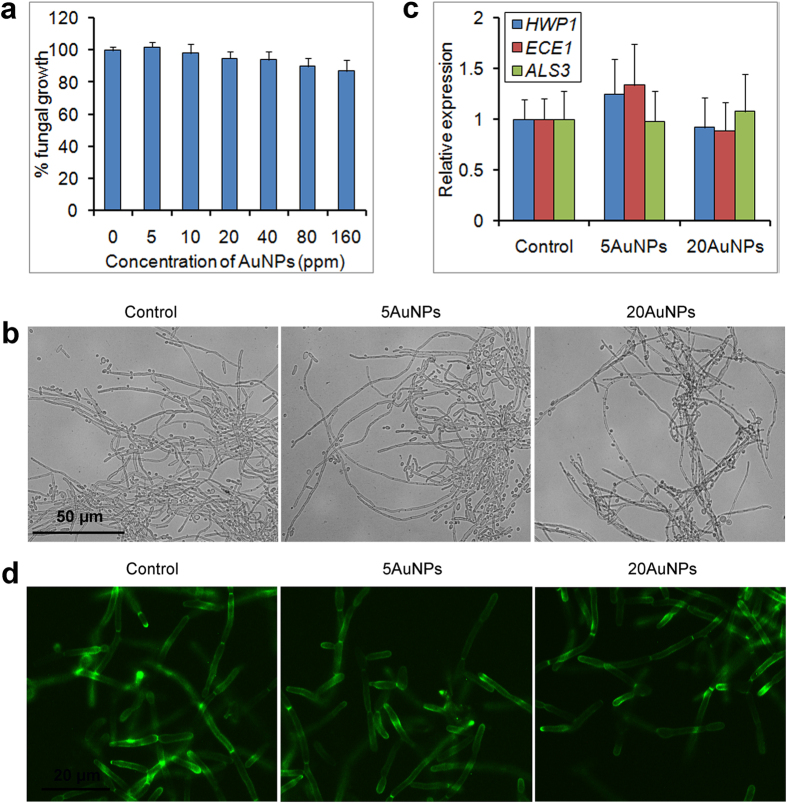
Normal growth and hyphal development of C. albicans treated by AuNPs.(a) The C. albicans cells were treated by AuNPs-S with different concentrations for 24 h, and cellular metabolic activity was determined by MTT assays. (b) Normal hyphal development of the fungal cells after 24 h of AuNP treatment. (c) Expression levels of hyphal-specific genes after 24 h of treatment. (d) Regular cell wall-localization of the hyphal-specific protein Hwp1 observed by fluorescence microscopy. The error bars indicate one standard deviations (n = 3).